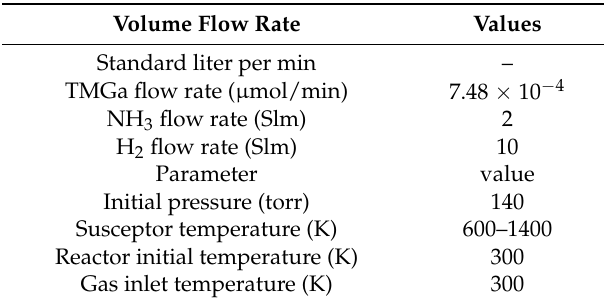
Table 4. Process parameters for the 0-D model